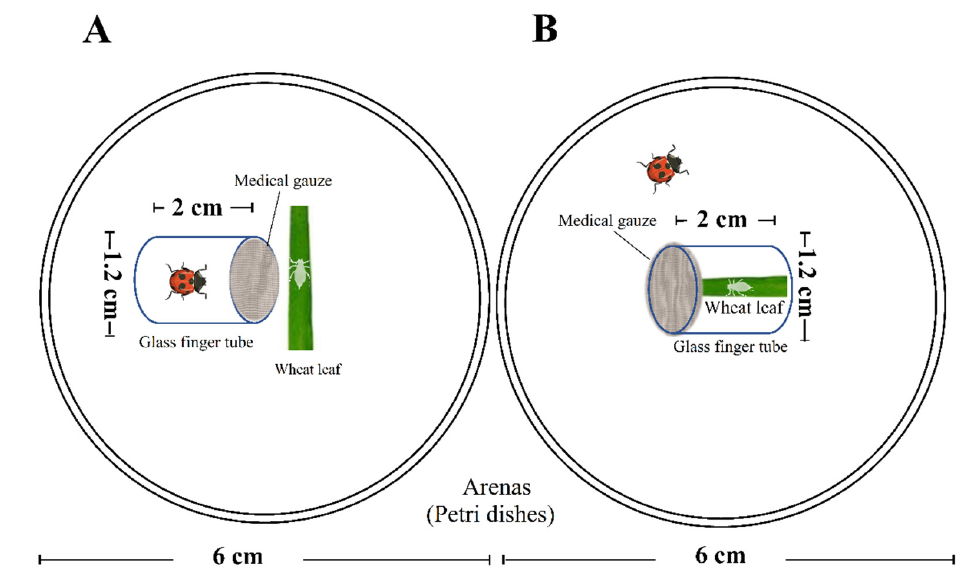
Figure 1. The experimental design for the caged predator model ( A ) and caged prey model ( B ). n = 30.